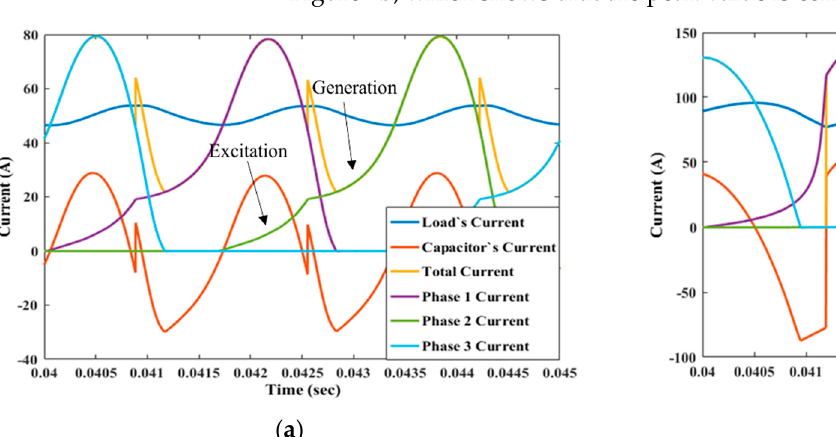
Figure 6. Current response at ( a ) V ref = 100 V, ( b ) V ref = 180 V.